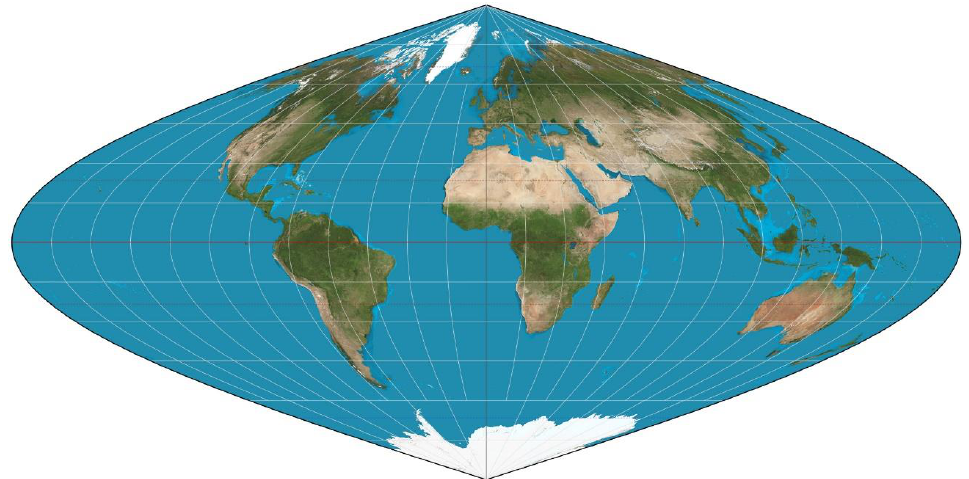
Figure 2. The Sanson–Flamsteed projection of the